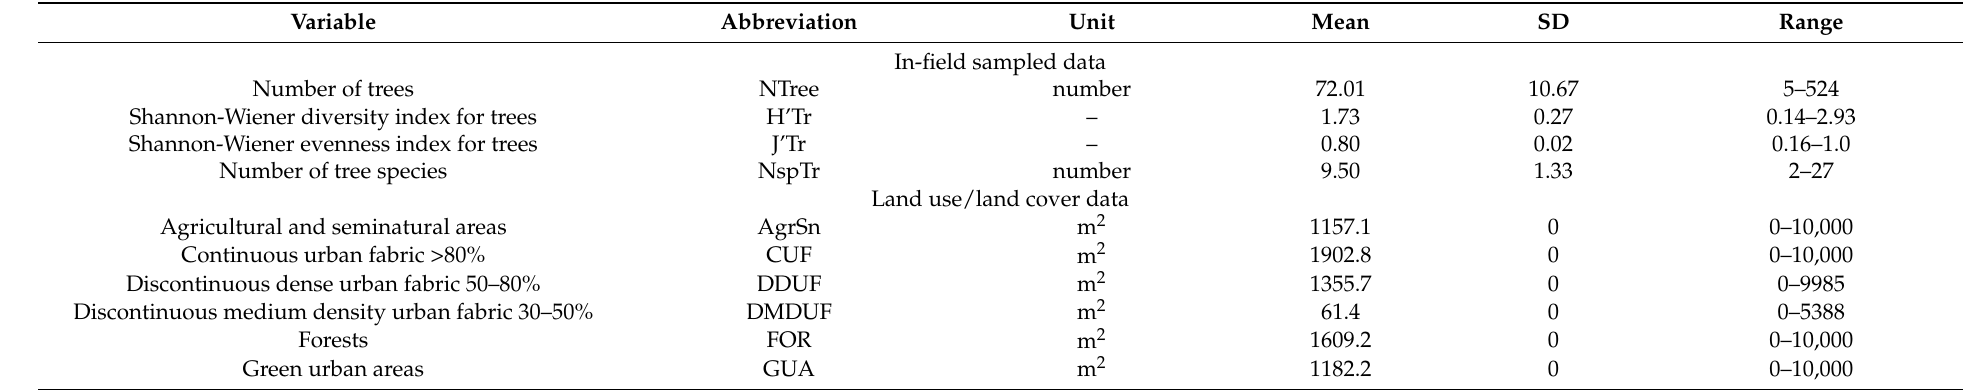
Table 2. Explanatory variables used in the epiphyte bryophyte species richness and diversity analyses. See Section 2.4 for broader